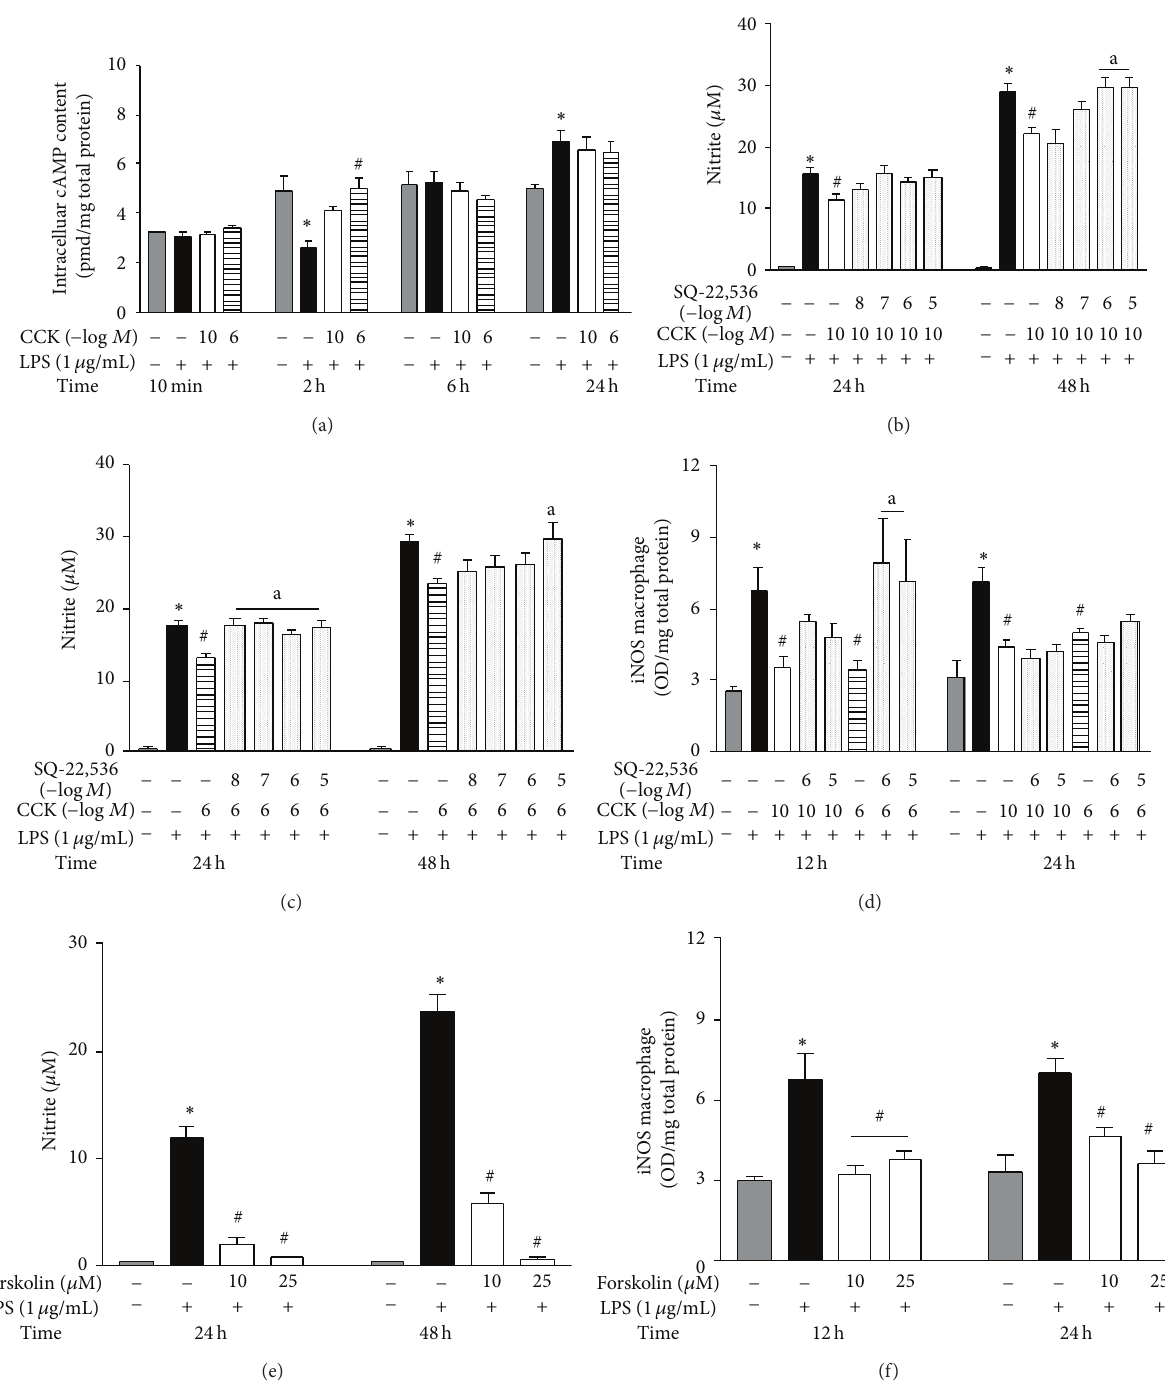
Figure 4: CCK increases cAMP formation which attenuates LPS-induced iNOS expression by peritoneal macrophages. The macrophage culture was pretreated with CCK (10 −10 or 10 −6 M) for 30 min before the addition of LPS (1 𝜇 g/mL) to the culture medium (time zero). At the indicated time-points, whole cell lysates were obtained for quantification of cAMP content by using ELISA kit (a), and samples were normalized with total protein concentration by Bradford method. To associate changes on intracellular cAMP with LPS-induced iNOS expression, the macrophage culture was incubated with an adenylyl cyclase inhibitor (SQ-22,536) (10 −8 –10 −5 M) (b, c, and d) for 30 min before the addition of CCK at 10 −10 or 10 −6 M. Thirty minutes later, cells were stimulated by LPS. Additionally, the peritoneal macrophage culture was pretreated with an adenylyl cyclase activator (forskolin) (10 and 25 𝜇 M) 30min prior to LPS (e and f). The culture supernatant was collected for nitrite quantification by Griess method and the iNOS synthesis was determined in cell lysates by ELISA. Data is a representative of three independent experiments with similar results. Values are expressed as means ± S.E.M. 𝑛 = 4–12 samples per group. ∗ 𝑃 < 0.05 versus saline, # 𝑃 < 0.05 versus LPS, and 𝑎 𝑃 < 0.05 versus respective CCK